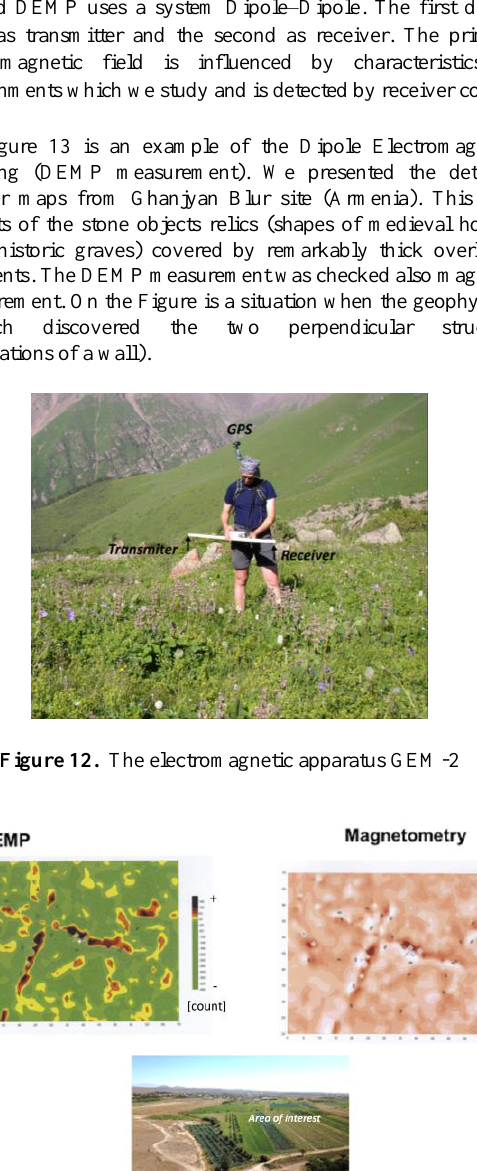
Figure 14. The radarograms with reflexes of the hidden fire reservoir from second war is presented on the Figure